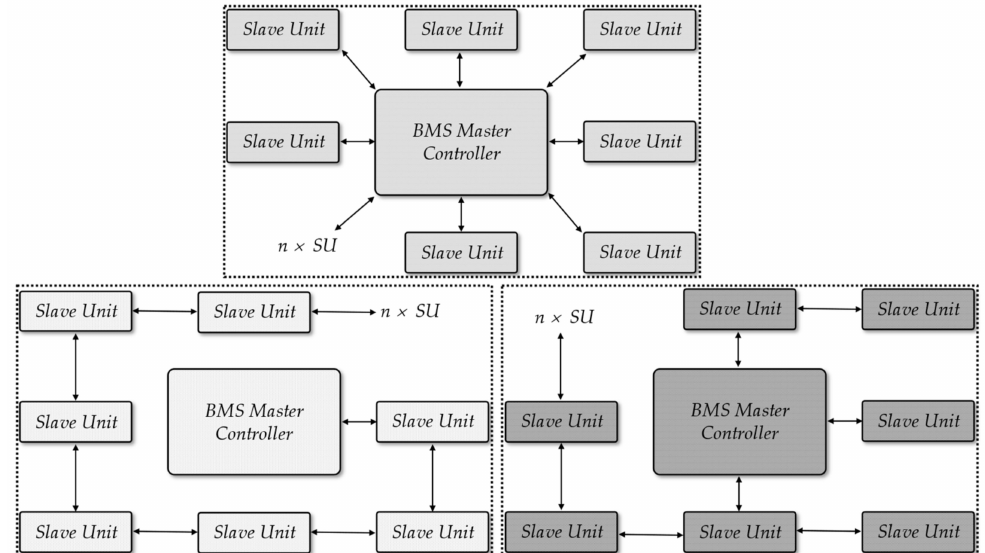
Figure 2. Exemplary structures of the distributed modular Battery Management